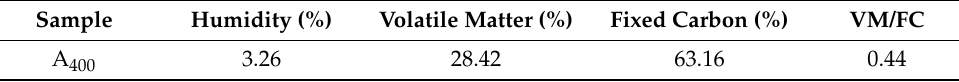
Table 5. Immediate analysis of the sludge generated in the treatment of the AS.